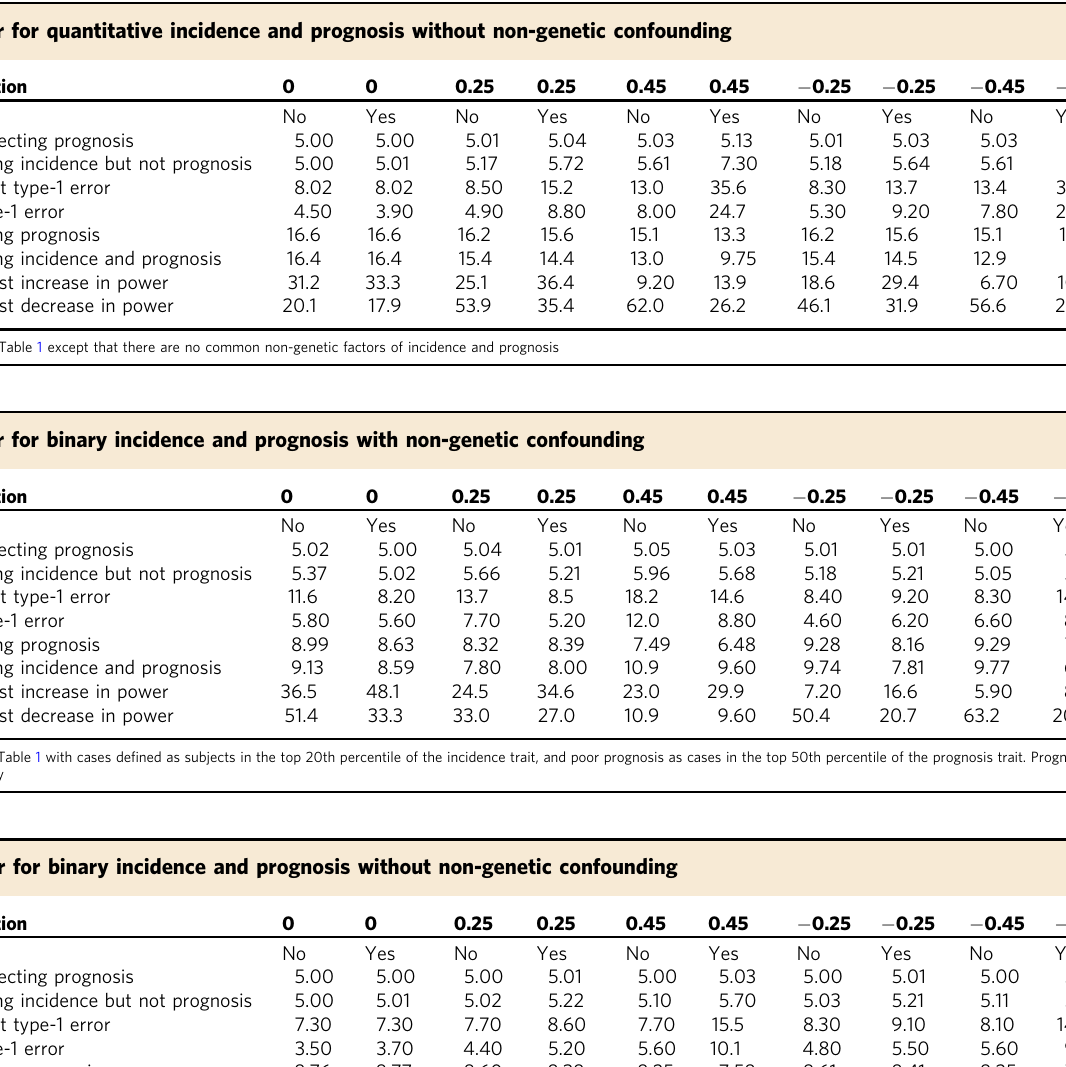
Parameters as in Table 3 except that that there are no common non-genetic factors of incidence and prognosis